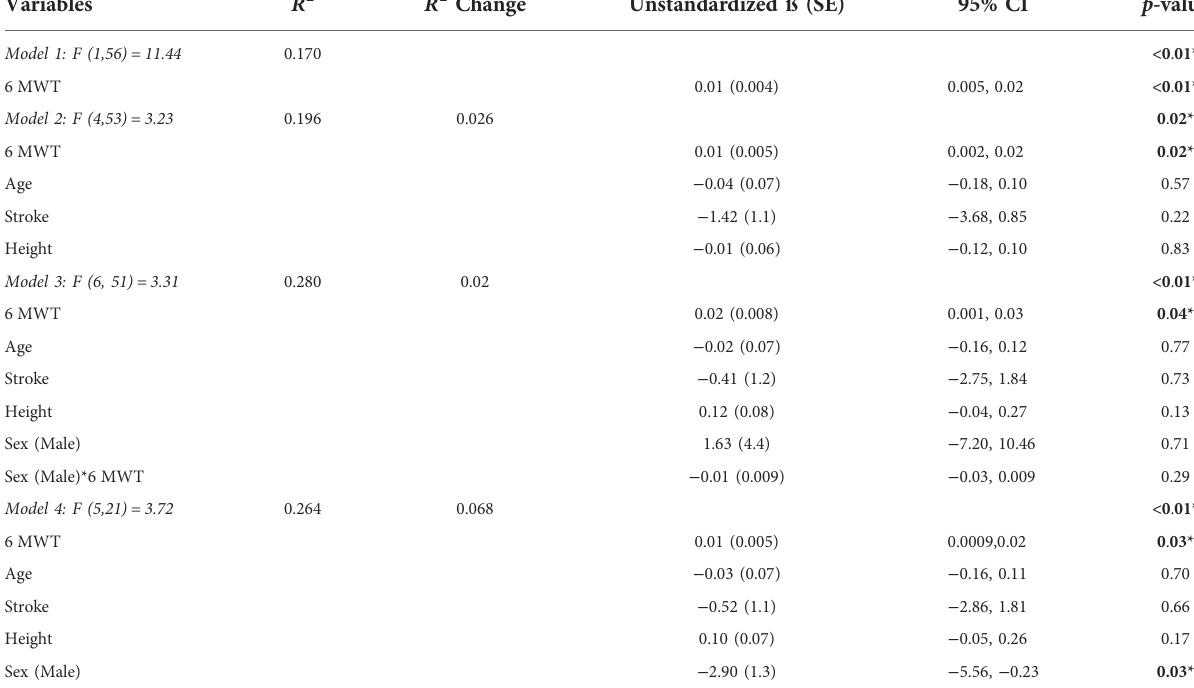
TABLE 2 Univariate and multivariable regression analyses examining the relationship between global cognitive function (Montreal Cognitive Assessment, dependent variable) and walking capacity (6-Minute Walk Test distance, independent variable) with models unadjusted (Model 1) and adjusted (Model 2), and sex (Model 3 for interaction, Model 4 for main